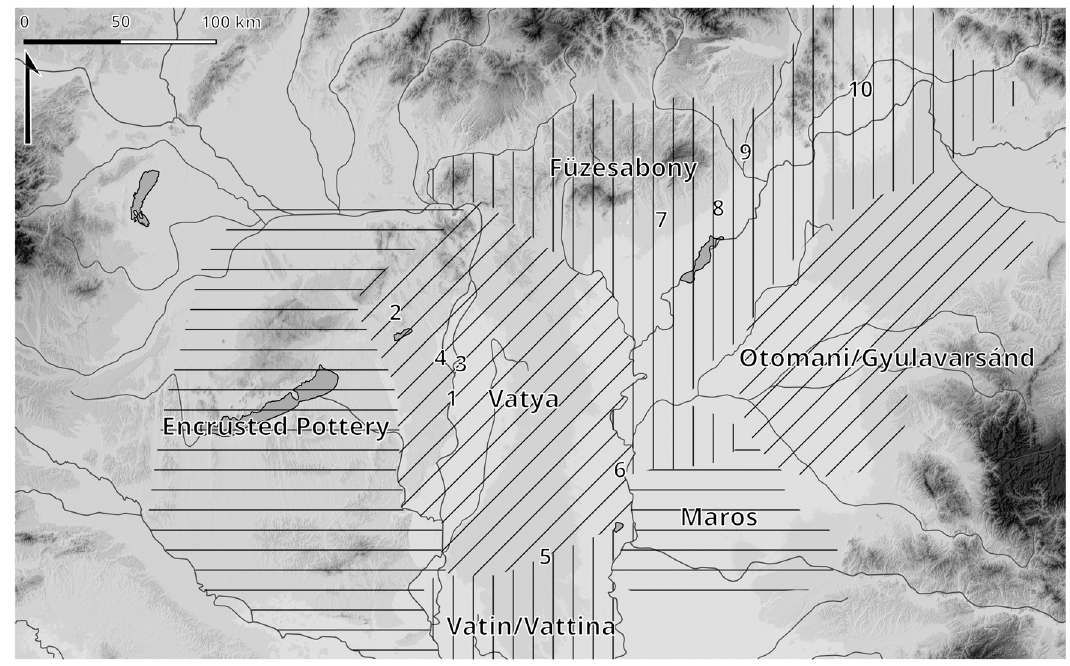
Figure 1: Distribution of Middle Bronze Age ( c. 2000 – 1500/1450 BCE ) cultural groups with distinct pottery styles in the Carpathian Basin after Fischl et al. ( 2013 ) and Stig Sørensen and Rebay - Salisbury ( 2008 ) , and the considered cemeteries of ( 1 ) Dunaújváros - Duna - d ű l ő , ( 2 ) Lovasberény, ( 3 ) Dömsöd, ( 4 ) Adony, ( 5 ) Kelebia, ( 6 ) Csanytelek - Palé, ( 7 ) Pusztaszikszó, ( 8 ) Gelej, ( 9 ) Hernádkak, ( 10 ) Streda nad